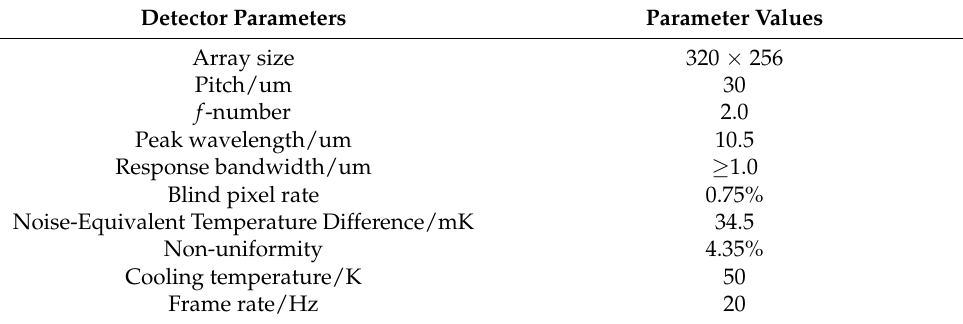
Figure 2. The cross-sectional figure of the QWIP. Table 1. The QWIP’s primary parameters.